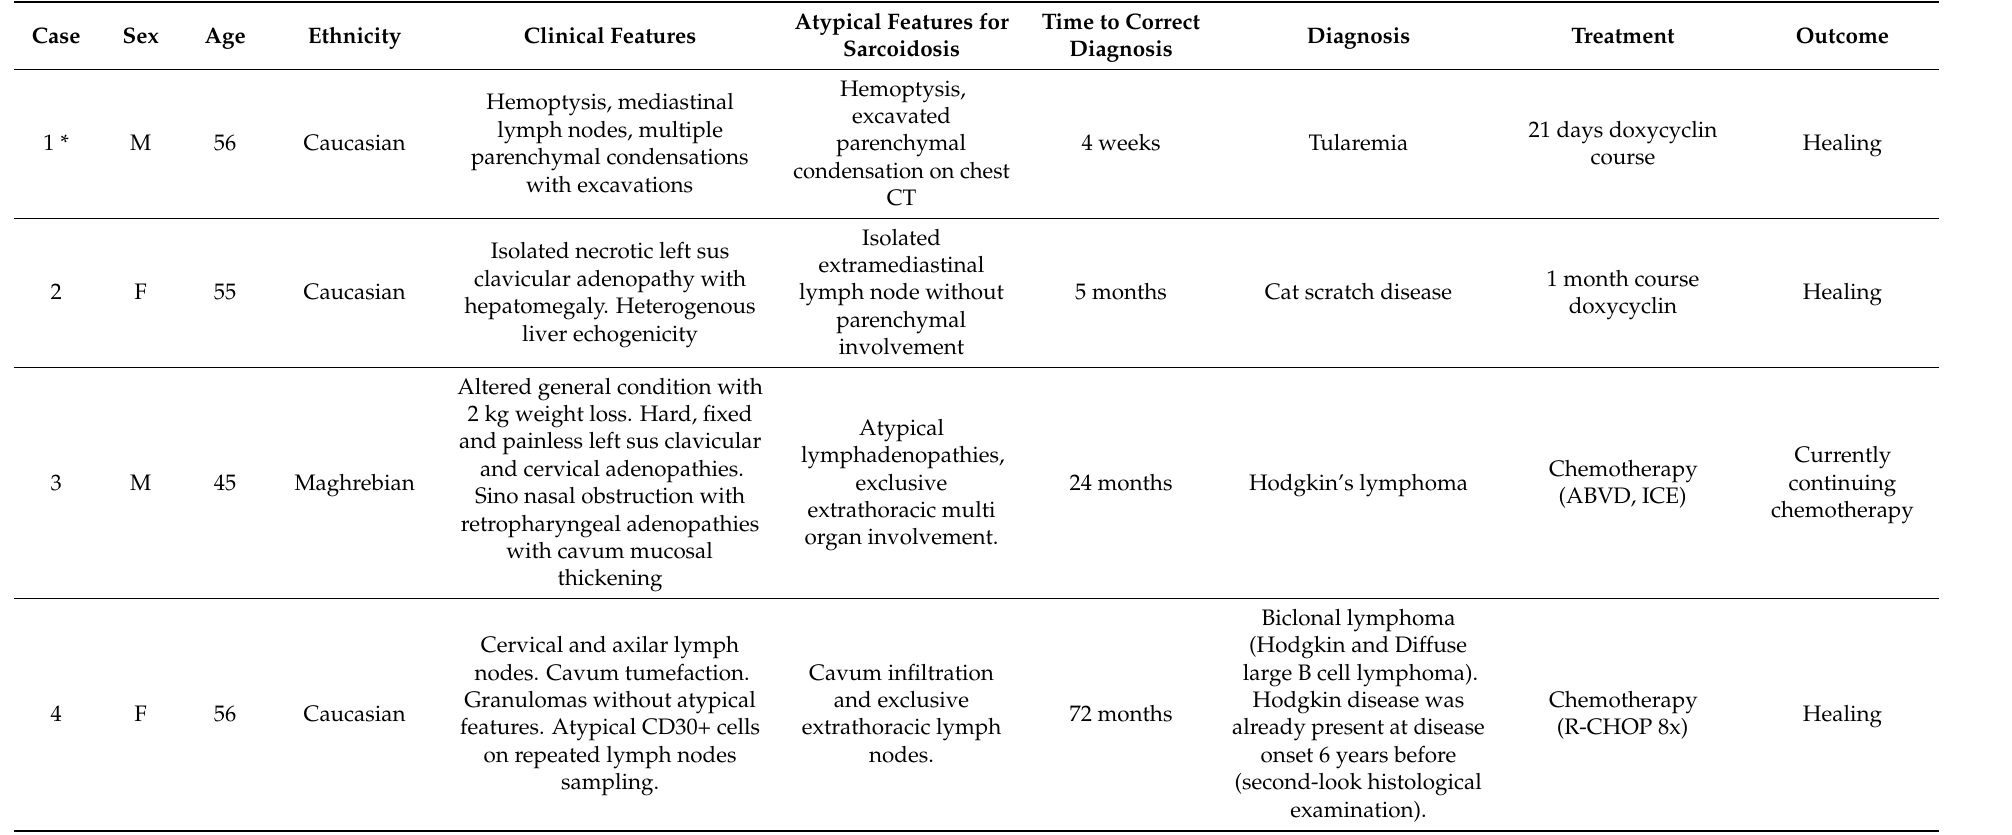
Table 6. Remaining cases with a wrong initial diagnosis of sarcoidosis in our tertiary